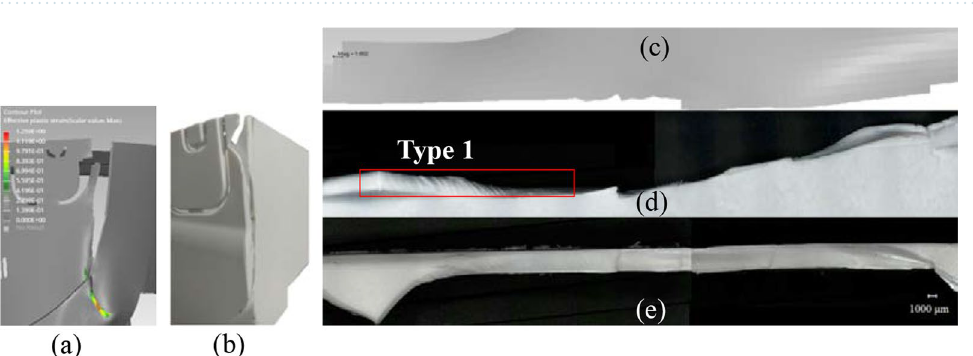
Figure 9. ( a ) Acceleration curves of digital twin and physical product of air conditioner unit (both filtered with SAE C60 standard) and ( b ) Energy map of the digital twin.